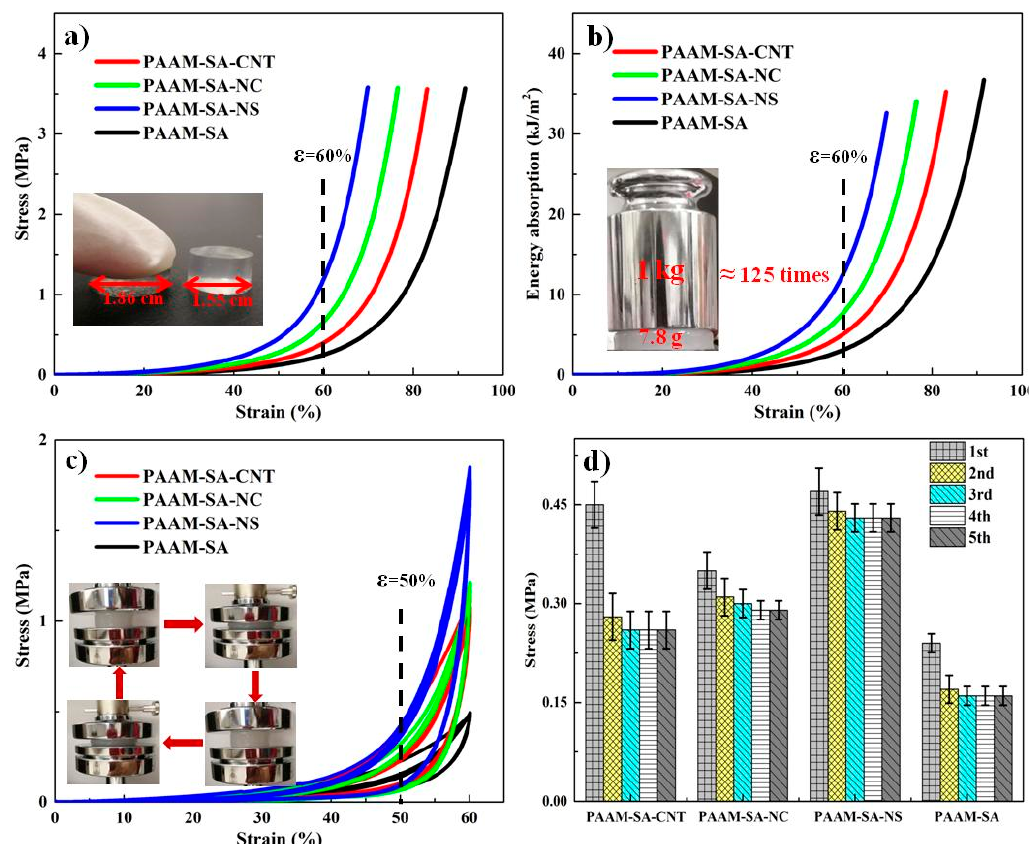
Figure 5. Compression stress–strain behavior of hydrogels: ( a ) compression plots; ( b ) energy absorption curves; ( c ) hysteresis of hydrogels for five cycles; and ( d ) stresses at 50% strain under five successive loadings.